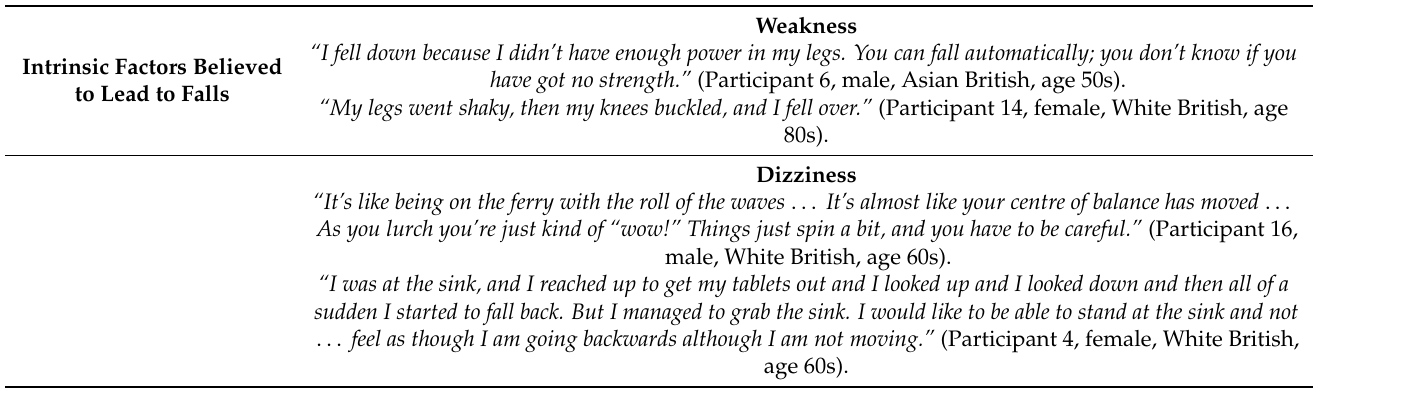
Table 2. Quotations illustrating participants’ perceptions of the cause of their